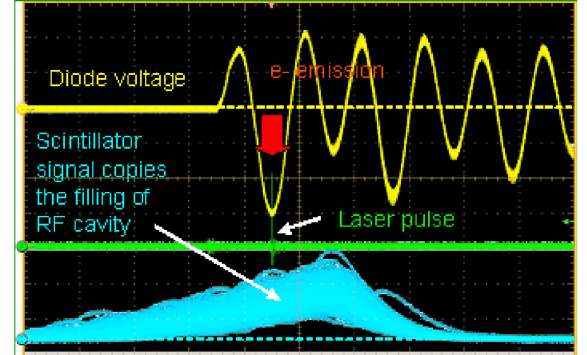
FIG. 15. Pulse voltage waveform (yellow) and x-ray scintilla- tor signal (blue). The laser pulse (green) is synchronized to the pulsed high-voltage source and illuminates the cathode when the negative bias voltage is the